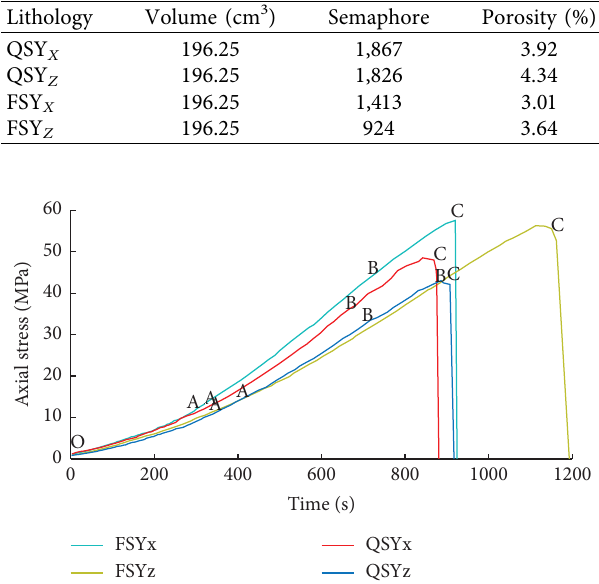
Figure 3: Axial stress-time curve of sandstone